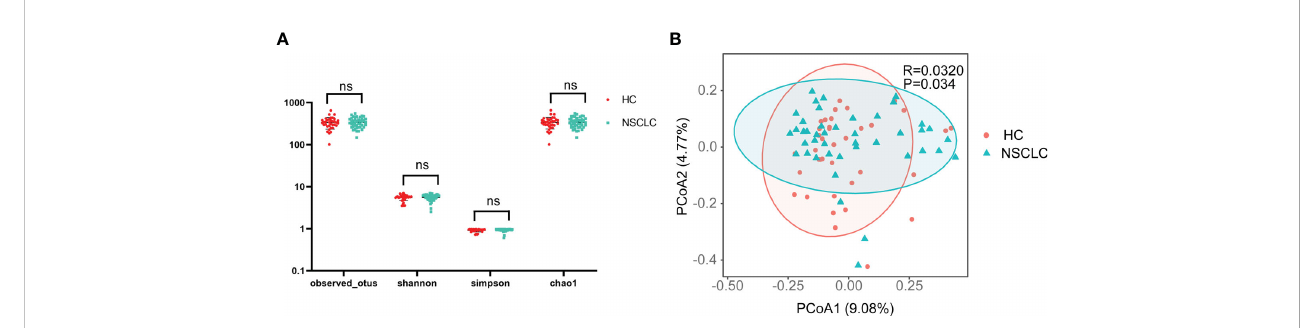
FIGURE 2 Comparison of a - and b -diversity of gut microbiota in HC and early-stage NSCLC groups (A) Differences in a diversity between early-stage NSCLC and HC based on the observed outs, shannon, simpson and chao1. (B) PCoA shows b diversity differences between the two groups (Bray-Curtis, R = 0.032, P< 0.05).